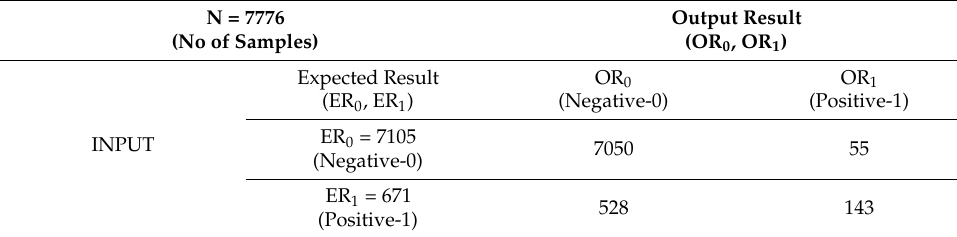
Table 9. KNN testing results.